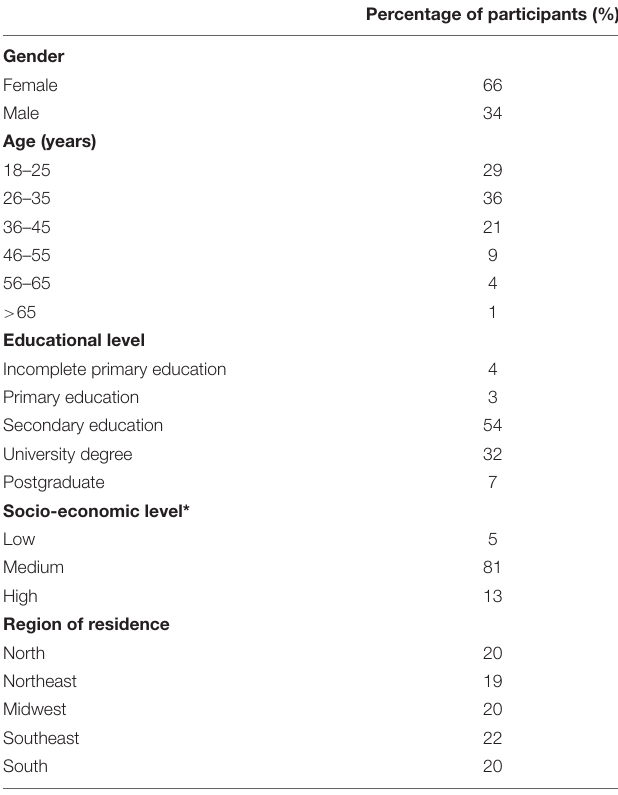
TABLE 1 | Socio-demographic characteristics of participants in the online study ( n =